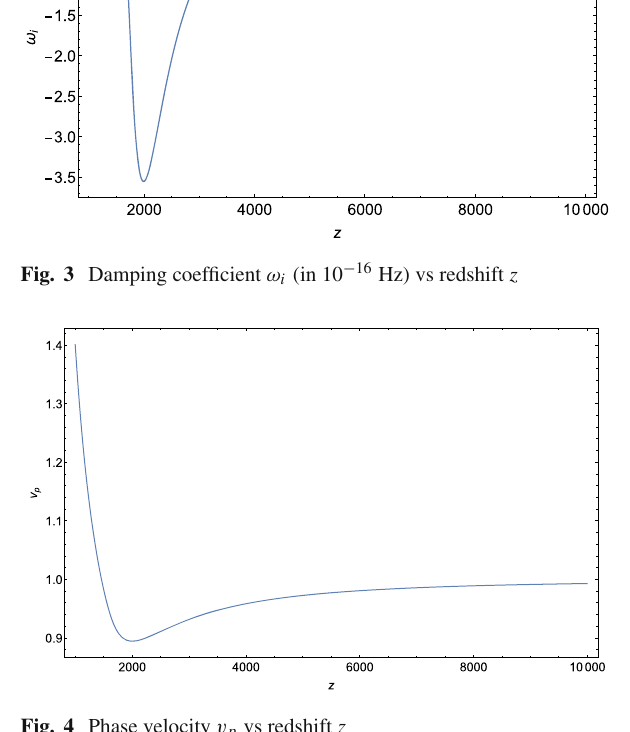
density, i.e. μ n ( 0 ) = 10 − 27 kg . We report the plot of the m 3 damping coefficient as function of the redshift for the chosen values of the physical parameters in Fig.